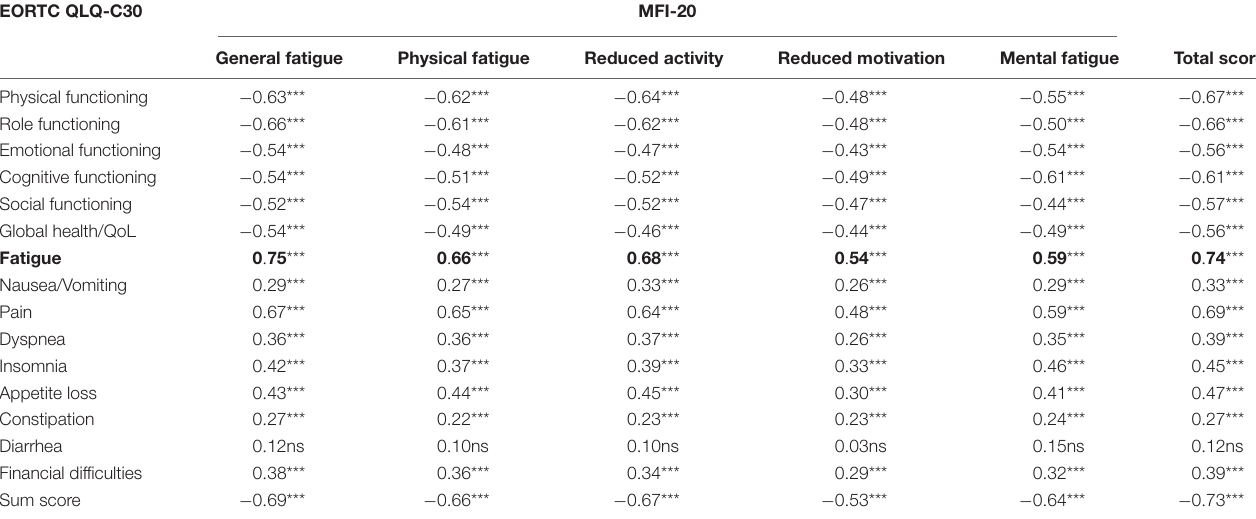
TABLE 4 | Correlations between the MFI-20 scales and the EORTC QLQ-C30 scales. EORTC QLQ-C30 MFI-20 General